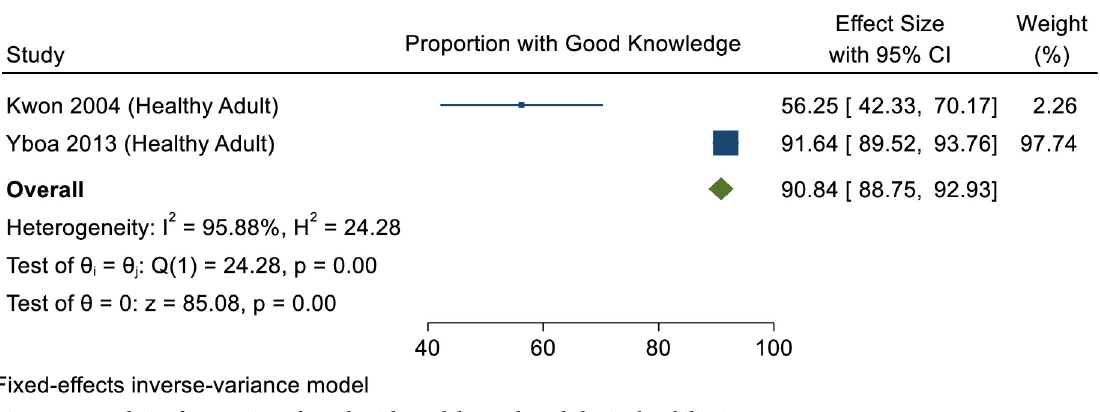
Fig 3. Meta-analysis of proportion of people with good dengue knowledge in the